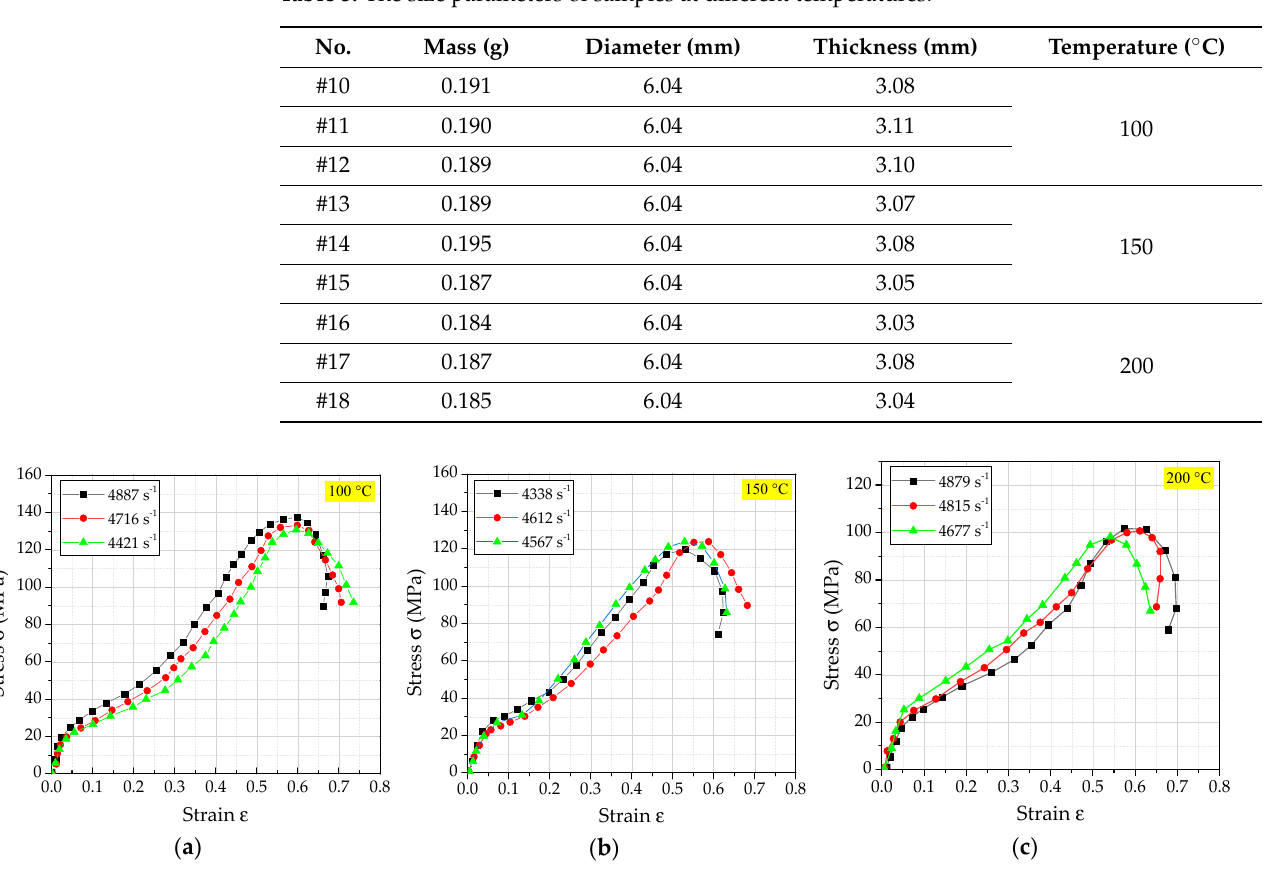
Table 5. The size parameters of samples at different temperatures.